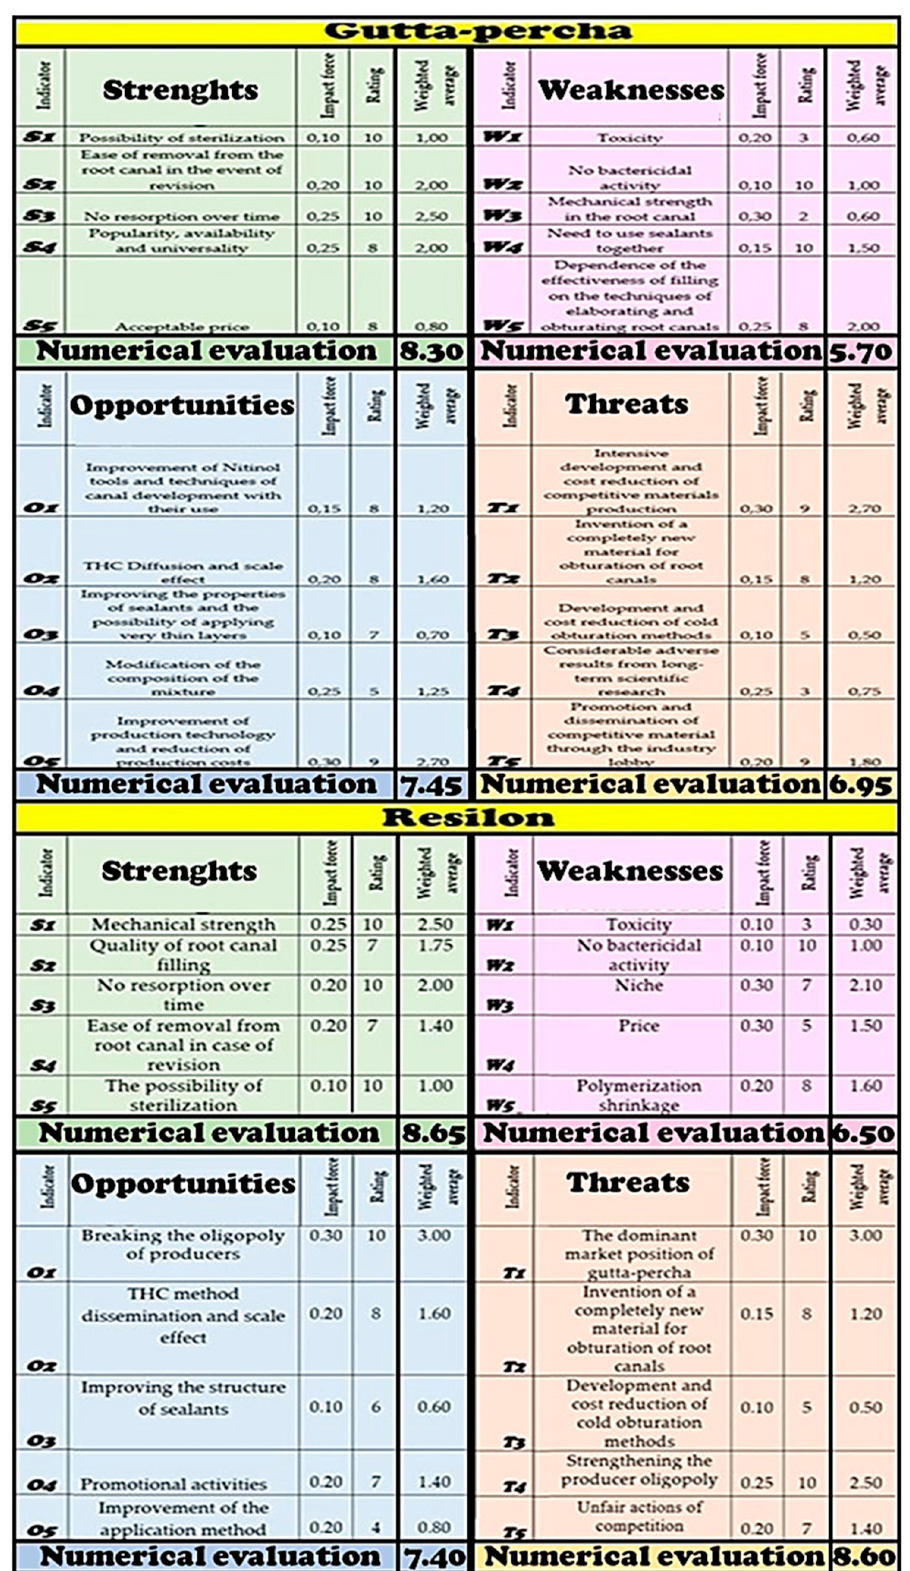
Figure 32. Criteria and results of the SWOT (strengths, weaknesses, opportunities, threats) point analysis concerning materials based on gutta ‐ percha and resilon as materials used for filling root canals in endodontics.